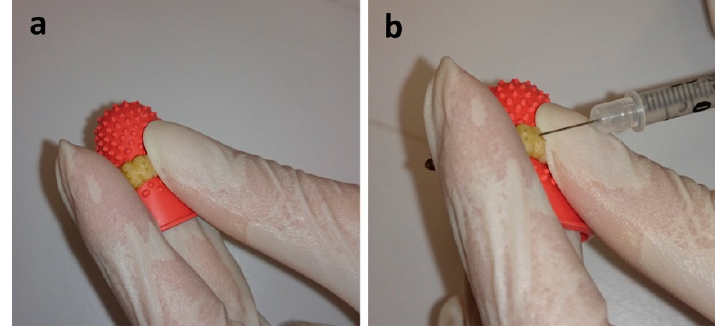
Figure 2. Inoculation of the larvae. Exposure of the pro-legs over the middle finger ( a ). Inoculation of the larvae into the last left pro-leg ( b